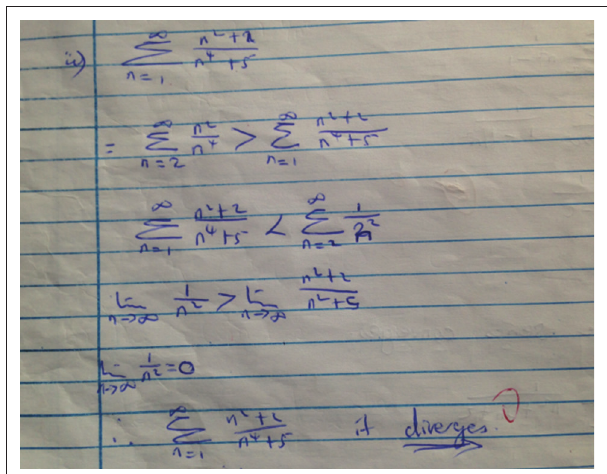
FIG URE 8: Written response of ST12 to task 1c